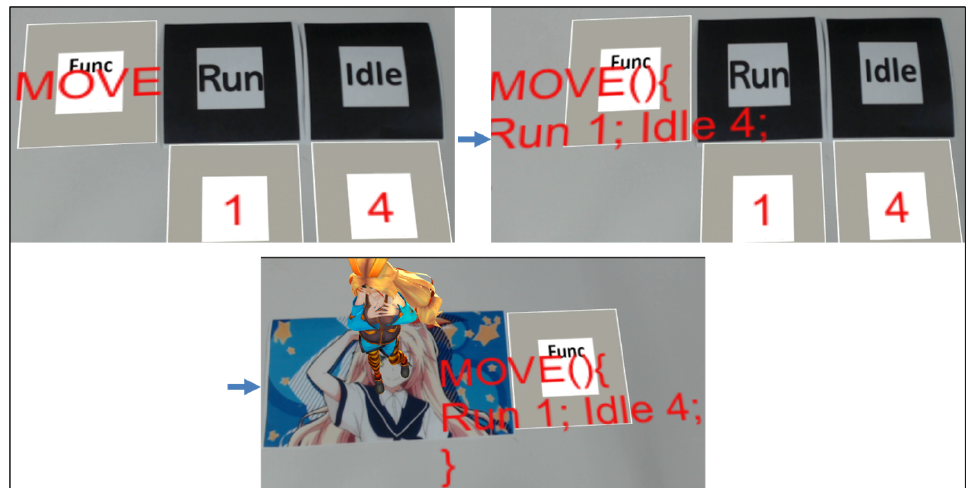
Figure 12. This is an example of controlling avatar actions. The markers are also read in depth-first traversal mode. The defined process is that the avatar will run for 1 second and then perform casual action for 4